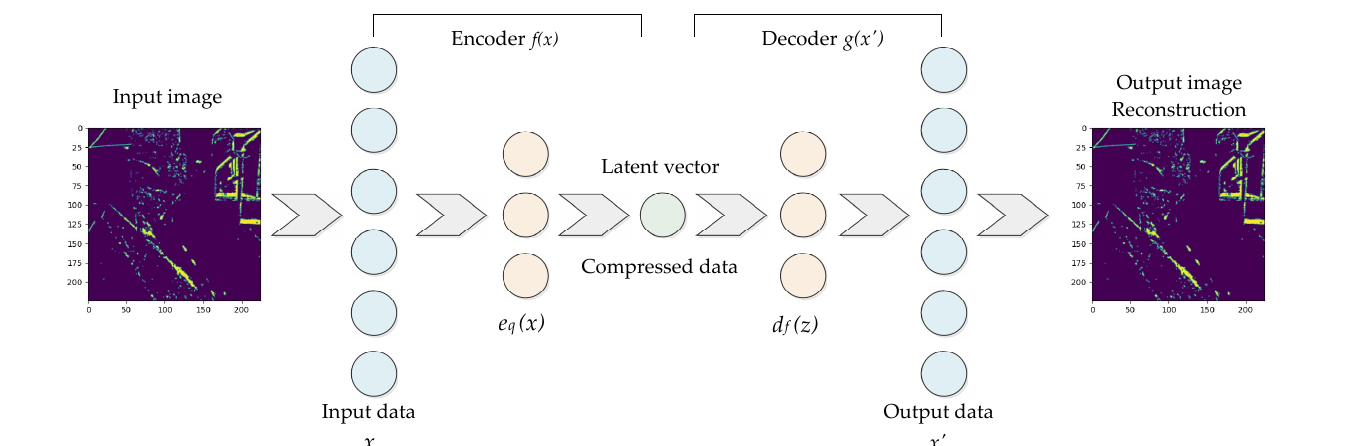
Figure 9. Autoencoder structure of a convolutional neural